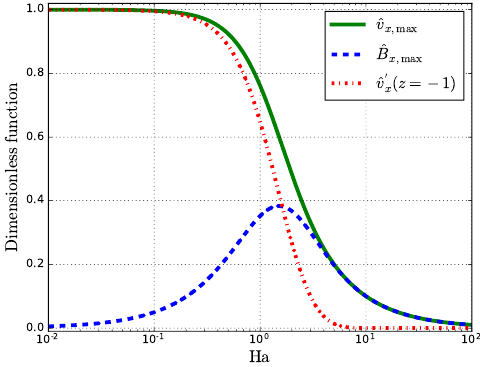
Relations (23) and (24) are shown in Figure 3.